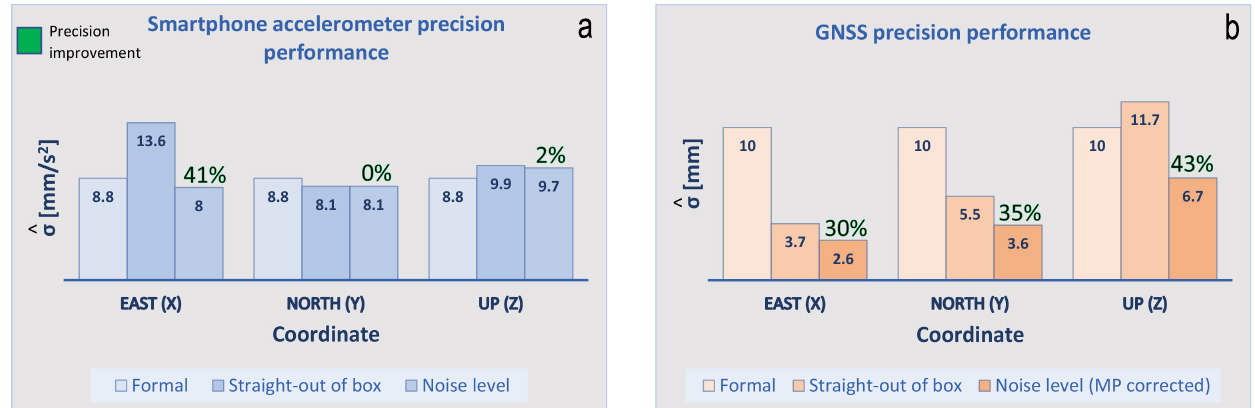
Figure 5. ENU precision results: ( a ) Smartphone accelerometer results indicate comparable precision relative to the specified formal precision value. The East straight-out-of-the-box precision is an exception due to accumulated drift error. Minor traces of precision degradation are visible in the Up component. Note that the formal precision value is derived based on a spectral noise parameter ( n A , nd ) of 180 derived in specific laboratory conditions at a constant temperature of 25 ◦ C [4]. ( b ) GNSS system-results show considerable discrepancies (precision ‘improvement’) between the straight-out-of-box and instrumental precision upon implementation of a GPS-only least squares (LS) -based MP correction.